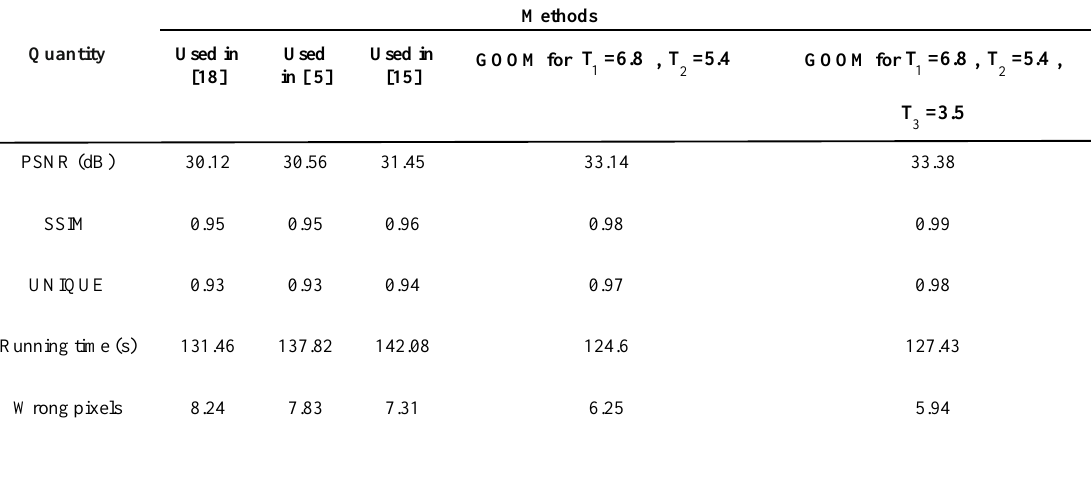
Table 9. Comparison of the proposed method with the other methods for "Laundry".